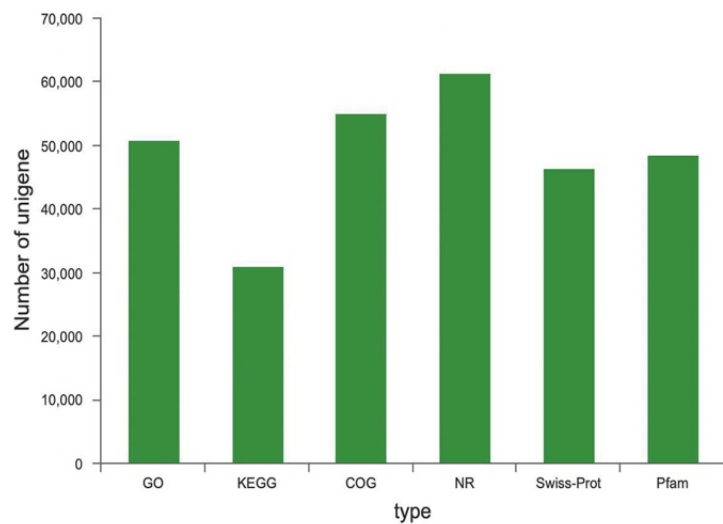
Figure 3. Functional annotation of unigenes.